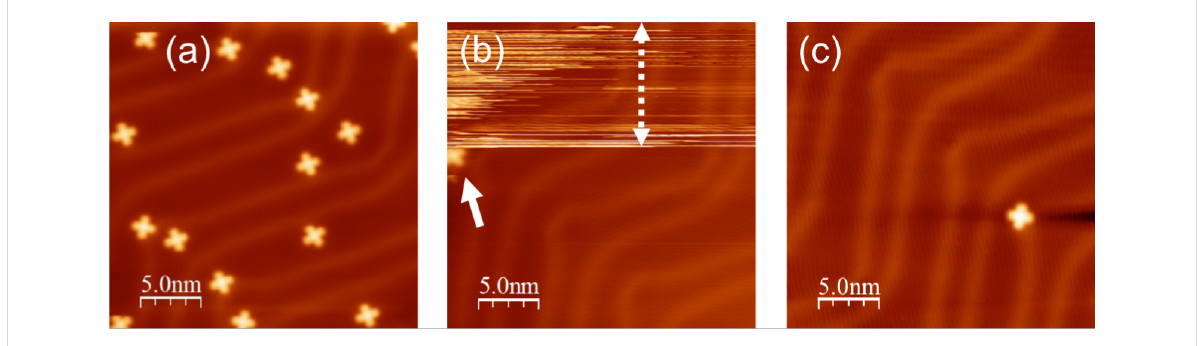
Figure 1: (a) STM image of MnPc molecules on the Au(111) surface (0.3 nA, − 0.25 V). (b) STM image of the bare Au(111) surface taken by the STM tip with (upper part) and without (lower part) a MnPc molecule attached to it (0.1 nA, − 0.25 V). A single MnPc molecule dropped from the tip during the scanning process (152.5 nm/s) at the position indicated by the arrow. (c) STM image of the MnPc molecule deposited in (b), (0.3 nA, − 0.25